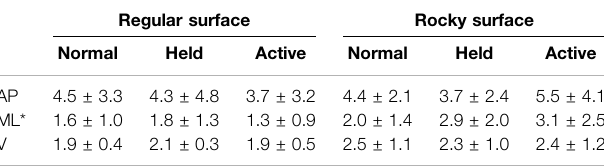
TABLE 1 | Trunk linear velocities (x10 − 3 m/s) according to surface type and arm swing strategy in all three directions. Regular surface Rocky surface